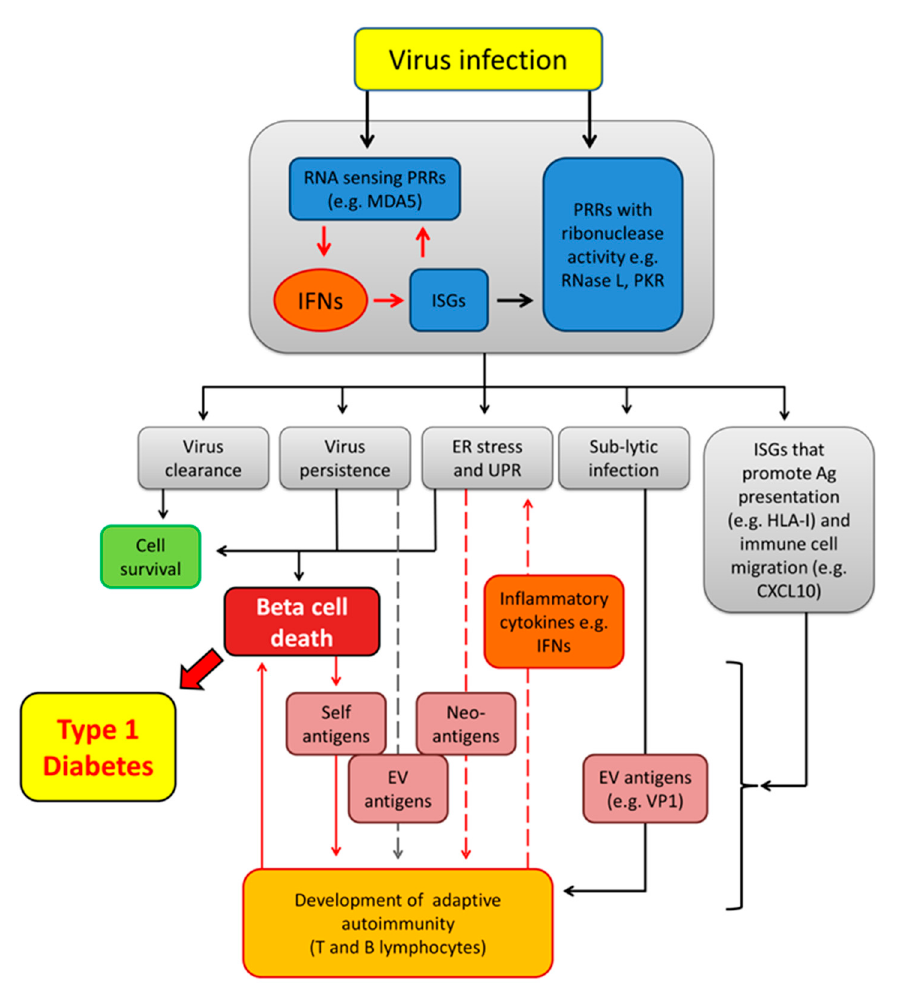
Figure 1. Virus-induced autoimmune T1D. An initial enterovirus (EV) infection activates pattern recognition receptors (PRRs) that induce interferons (IFNs) and interferon stimulated genes (ISGs) as well as PRRs that directly target and cleave viral RNA, driving a collective intrinsic antiviral response that may lead to virus clearance or virus persistence. The surge in IFNs and ISGs promotes Endoplasmic Reticulum (ER) stress and unfolded protein response (UPR) which, alone or in combination with virus infection, may lead to programmed cell death (apoptosis), exposing virus and self-antigens to the immune system. In addition, IFNs promote antigen presentation and immune cell migration by inducing the expression of human leukocyte antigen class I (HLA-I) molecules and chemokines such as C-X-C motif chemokine 10 (CXCL10). Cells with lytic or persistent infection that do not undergo apoptosis may present viral antigens (e.g., VP1) and self-antigens (including neo-antigens induced by IFNs and UPR) to the immune cells (APCs, CD8+ and CD4+ T cells) leading to development of autoantibodies and an adaptive autoimmune response against antigen producing cells. Islet infiltrating immune cells may also contribute to ER stress and UPR in beta cells by releasing inflammatory cytokines such as IFN α and IFN γ . MDA5, melanoma differentiation-associated protein 5; PKR, protein kinase R; VP1, virus capsid protein 1. Type I IFNs have been described as key regulatory links between the innate and adaptive immune response due to their ability to activate genes that are involved in modulating such